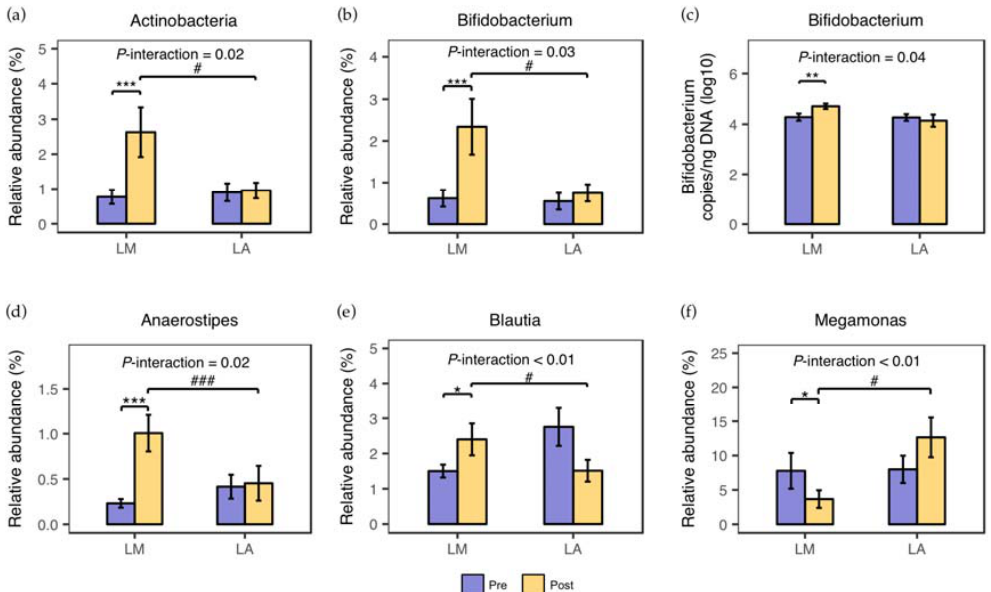
Figure 1. Alternations in gut microbiota composition following four-week supplementation of whole milk in lactose malabsorbers (LM) and absorbers (LA). ( a – f ), The relative abundance of Actinobacteria ( a ), Bifidobacterium assessed using Illumina 16S rRNA gene sequencing ( b ) and quantitative real-time Polymerase Chain Reaction ( c ), Anaerostipes ( d ), Blautia ( e ), and Megamonas ( f ) before and after 4-week supplementation of whole milk in LM ( n = 31) and LA ( n = 29, two participants were excluded during the gut microbiota analysis owing to antibiotics consumption during the intervention period for upper respiratory tract infection). Data are presented as Mean ± SEM (*, P < 0.05, **, P < 0.01, ***, P < 0.001 for within-group difference; # , P < 0.05 and ### , P < 0.001 for between-group difference).